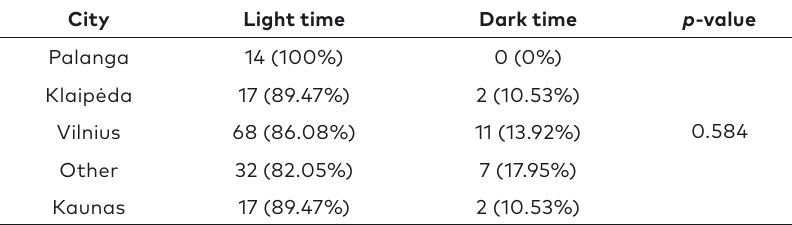
Table 5. The distribution of injuries by time of the day and by city in 2019–2020 City